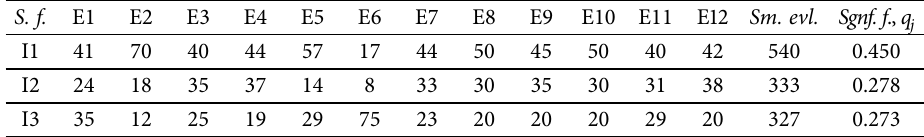
Table 22. The significance of factors in the group of the internal policy of the institution regarding the commercial potential of technologies S. f.